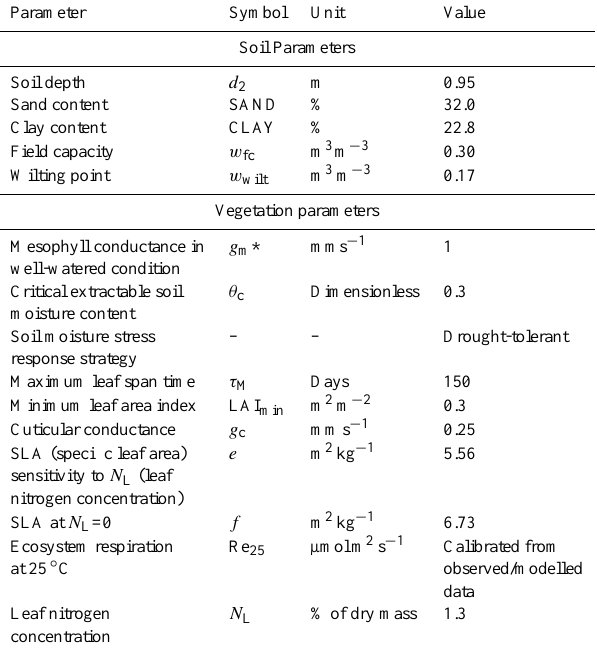
Table 1. Main soil and vegetation parameters used for the SMOSREX grassland in the ISBA-A-gs